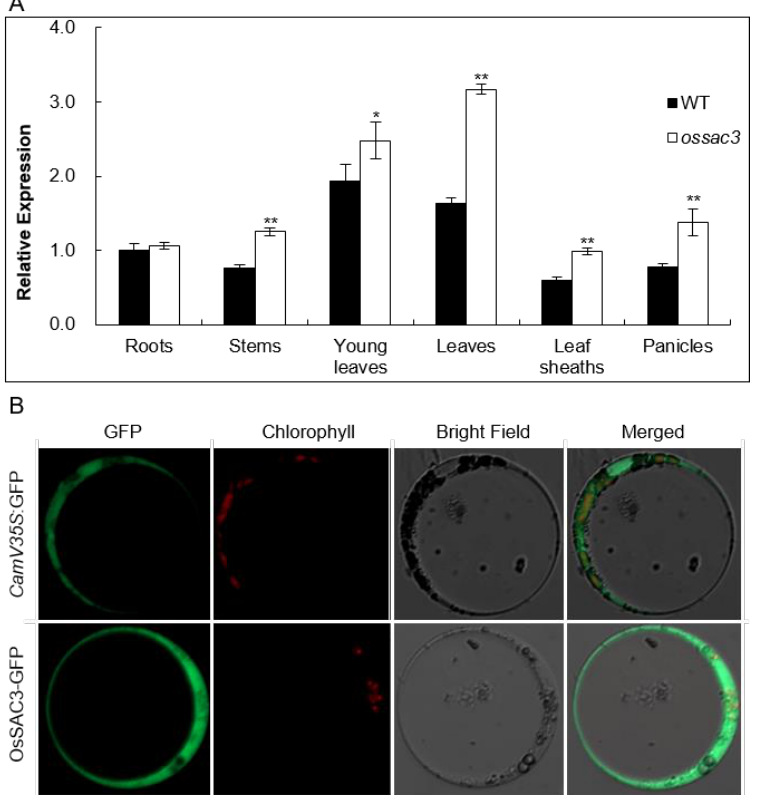
Figure 3. Expression and subcellular analysis of OsSAC3. ( A ): Expression pattern of OsSAC3 ; OsSAC3 was expressed in roots, stems, leaves, leaf sheathes and panicles. Additionally, increased expression of OsSAC3 was observed in the ossac3 than the wild type (WT). Three biological repeats were conducted. * and ** represent p < 0.05 and p < 0.001, respectively, determined by Student’s t -test; ( B ): Subcellular analysis of OsSAC3. OsSAC3 was located in the cytoplasm.